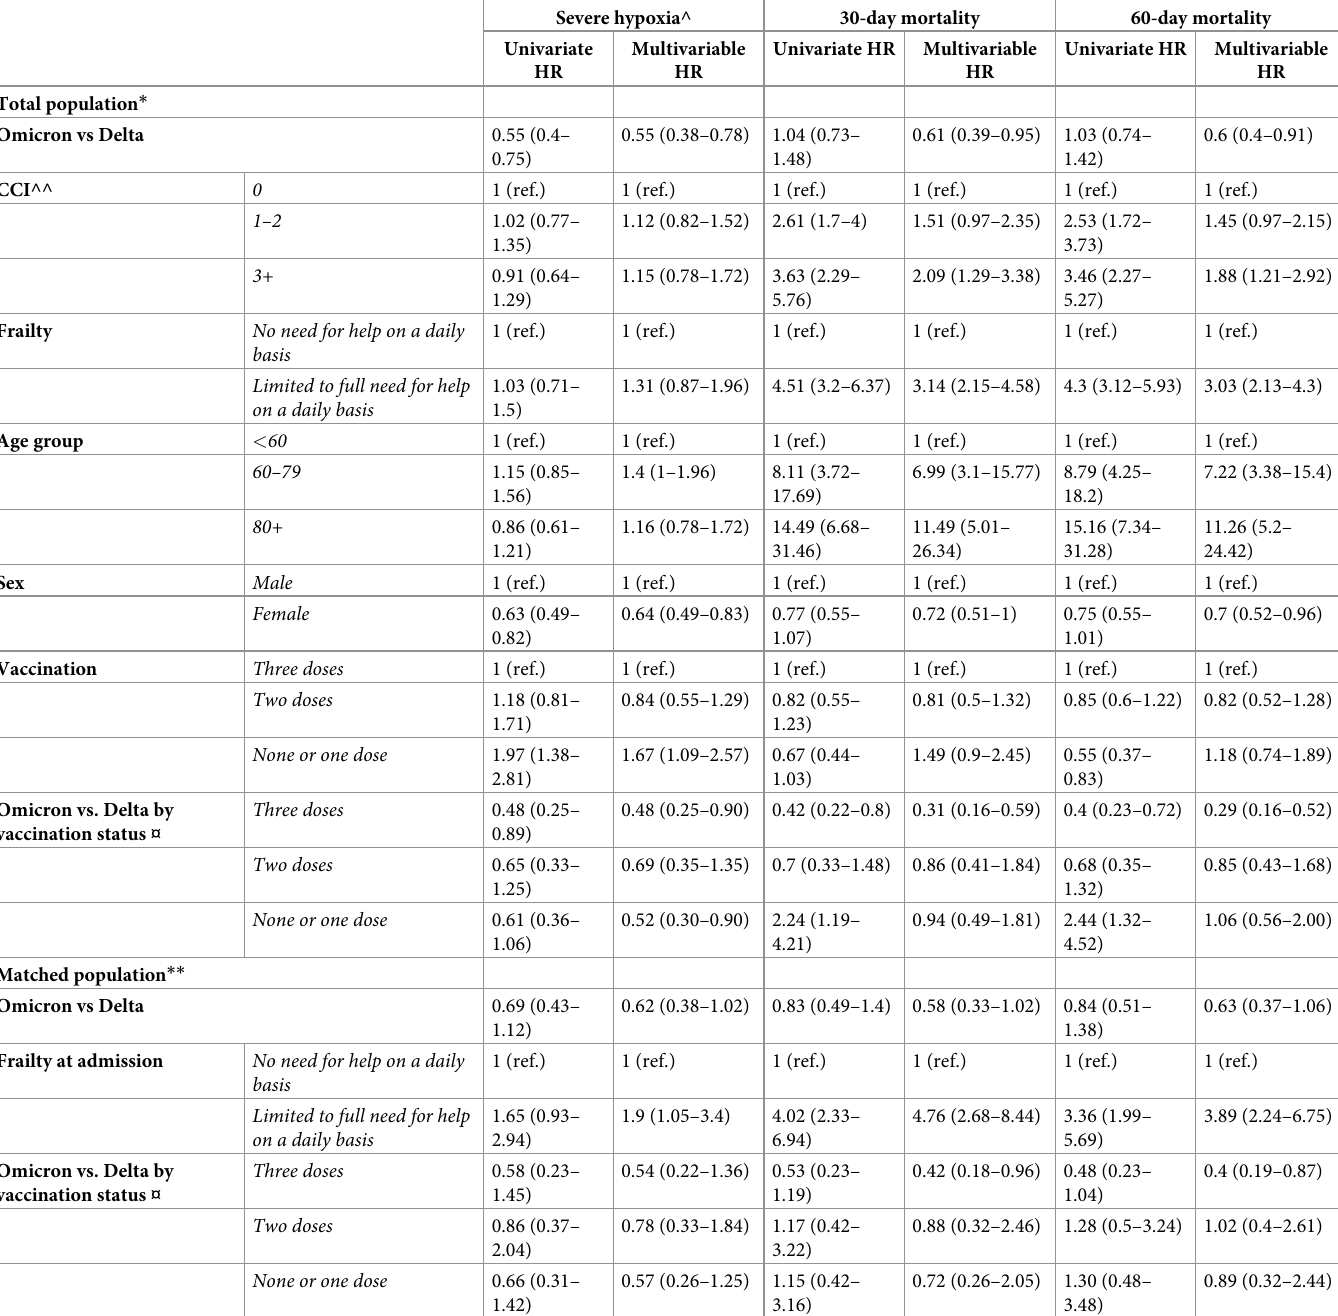
Table 4. Univariate and multivariable hazard ratios for severe hypoxemia, 30-day all-cause mortality, and 60-day all-cause mortality, after COVID-19 hospital admission with Delta or Omicron SARS-CoV-2 variants in the total study population ( n = 1043) and in the matched study population ( n =